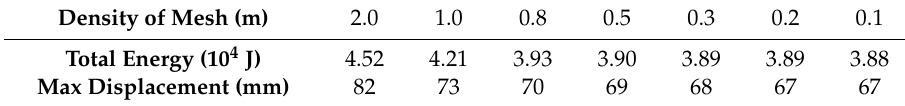
Figure 8. Model of the vertical view, the plan view and the detonation arrangement. ( a ) Vertical view. ( b ) Plan view.